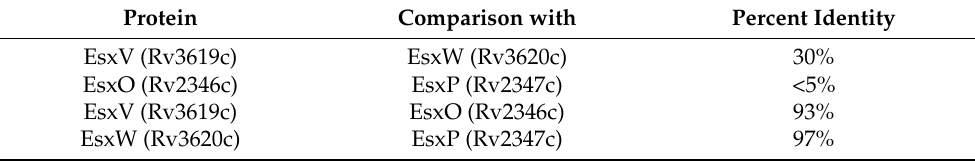
Table 6. The amino acid sequence identities between ESAT6-like proteins encoded by RD7 and RD9. Protein Comparison